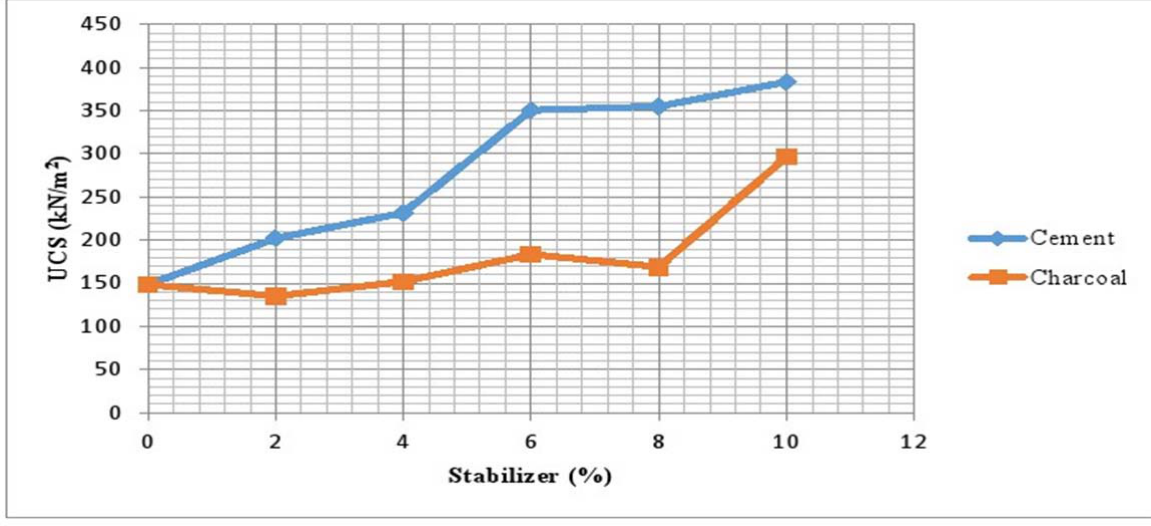
Figure 5. Variation of UCS with percentage of